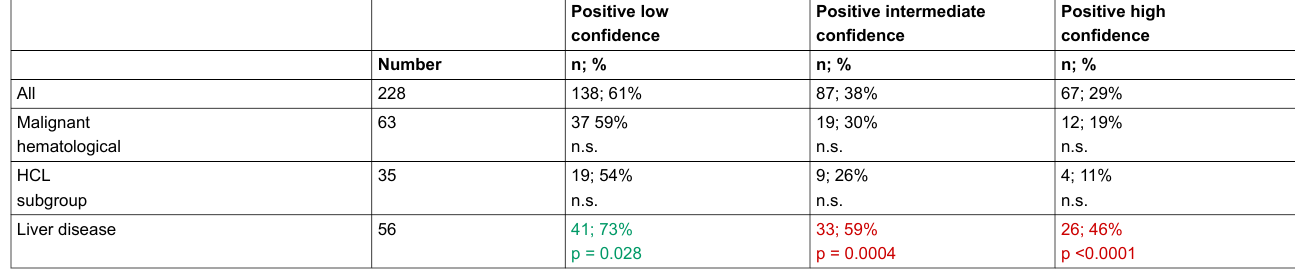
Table S1: Positive tests in different diagnosis groups. Patients were analysed according to their underlying diagnosis in a similar analysis to that presented in table 3; however, the whole patient population, including patients with normal size spleens, was considered. For each level of confidence the number of positive tests is given